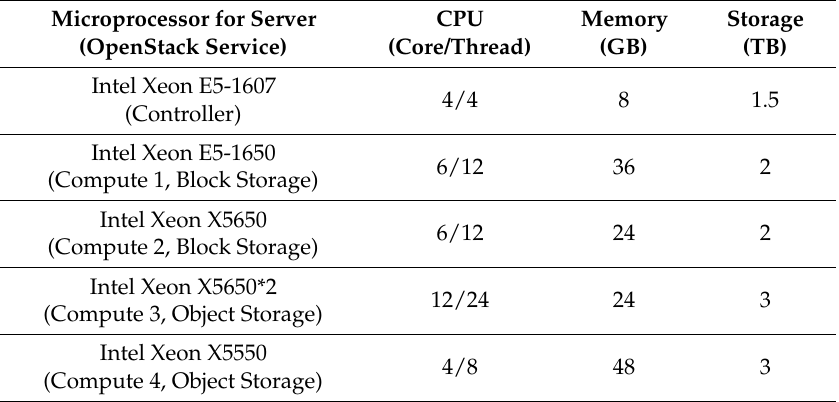
Table 1. Physical servers used in this